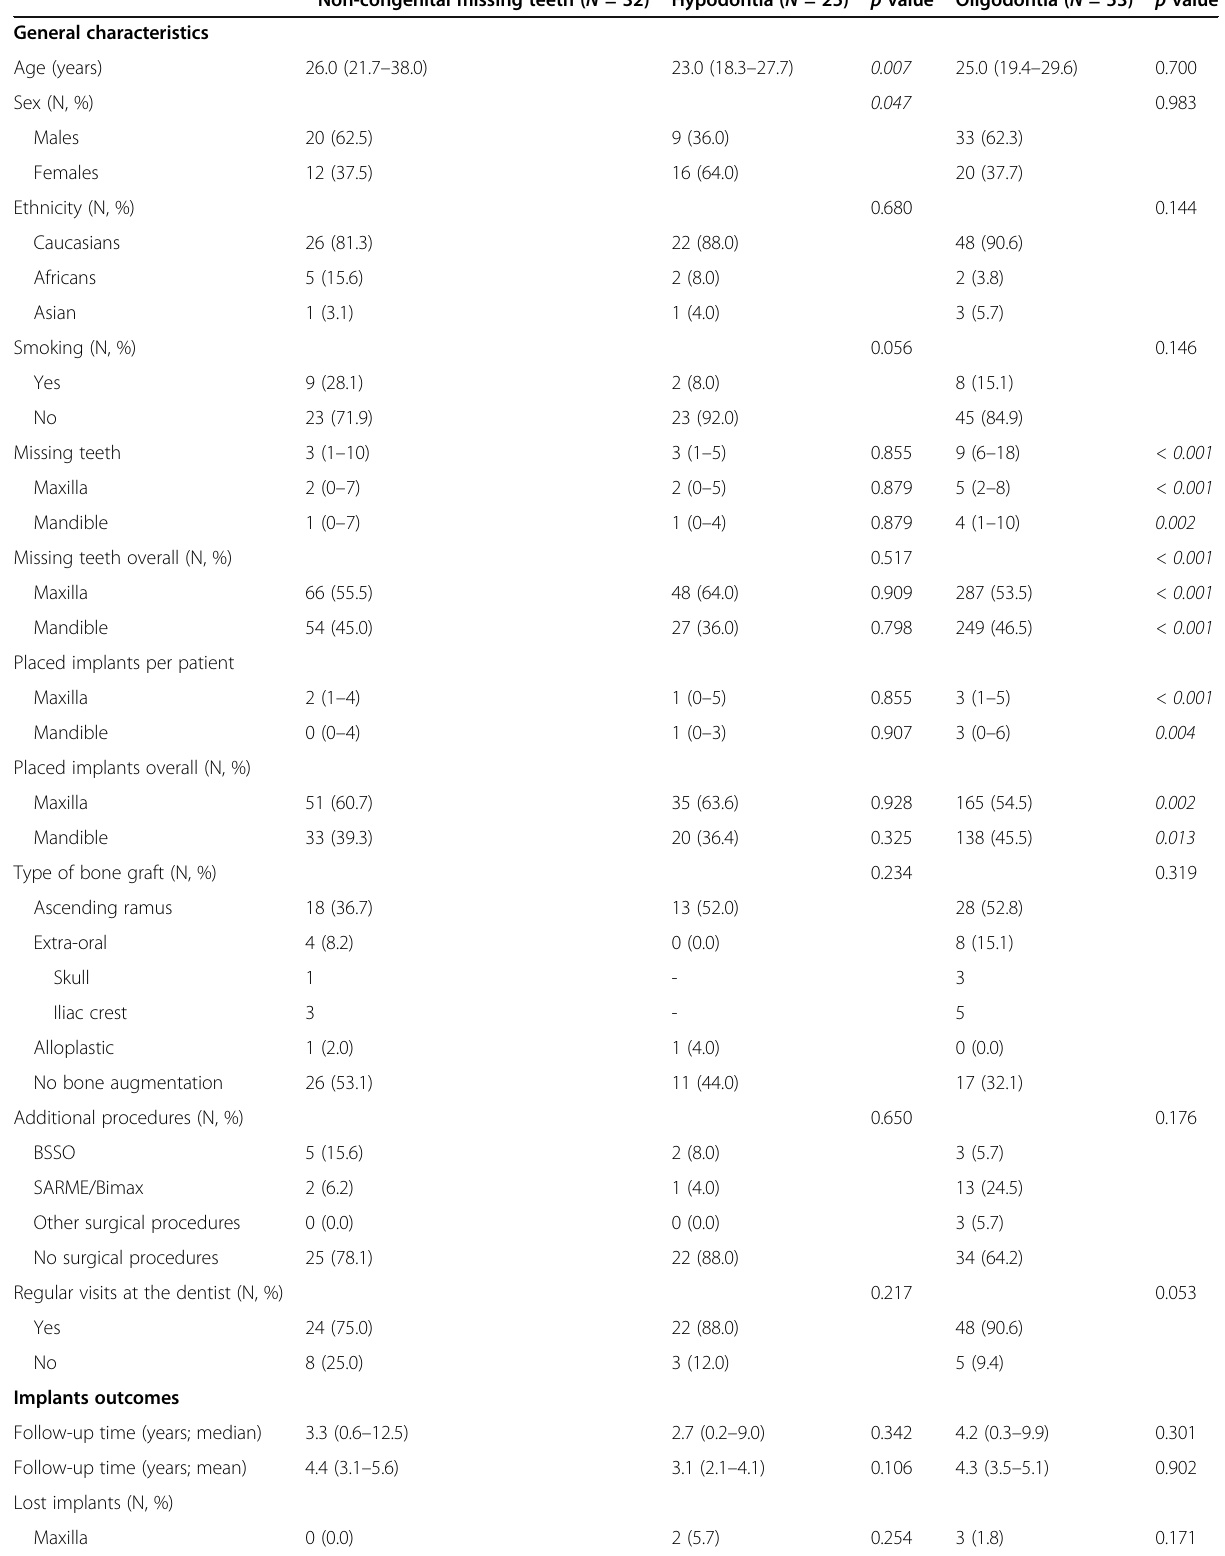
Table 2 Baseline characteristics of the study